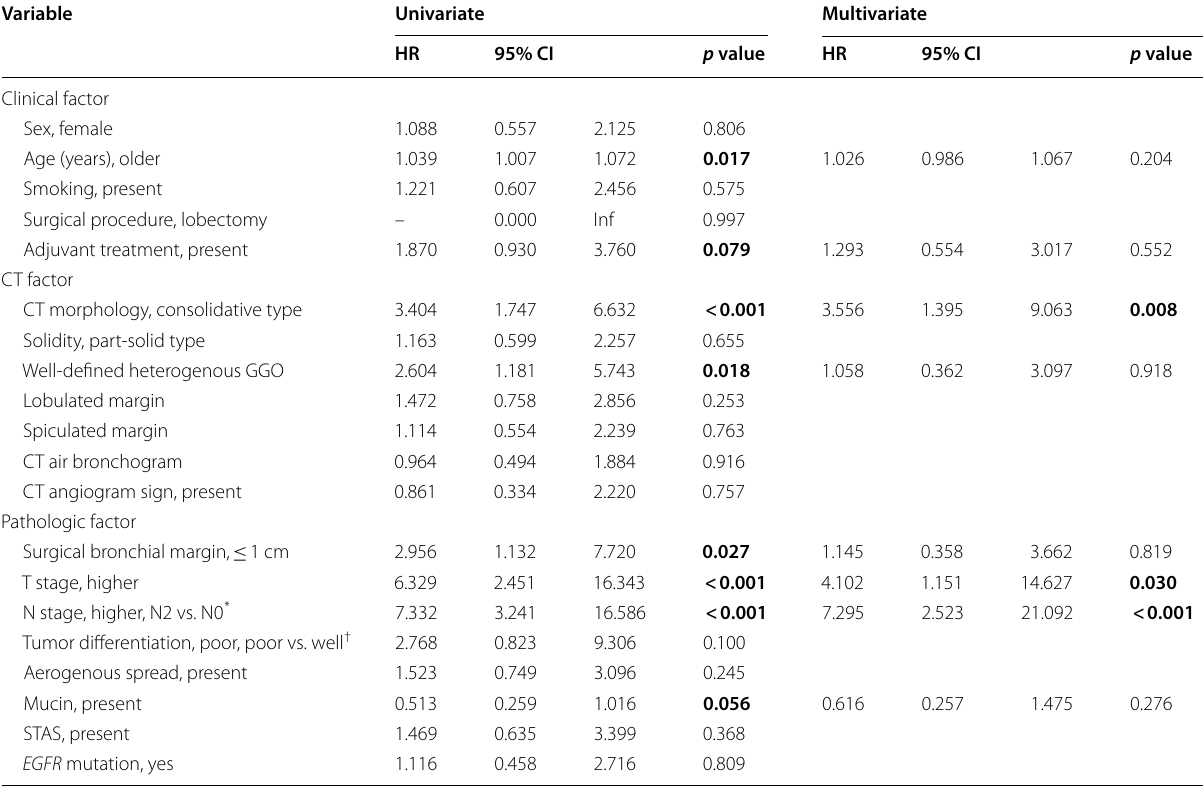
Table 3 Results of univariate and multivariate analyses of disease-free